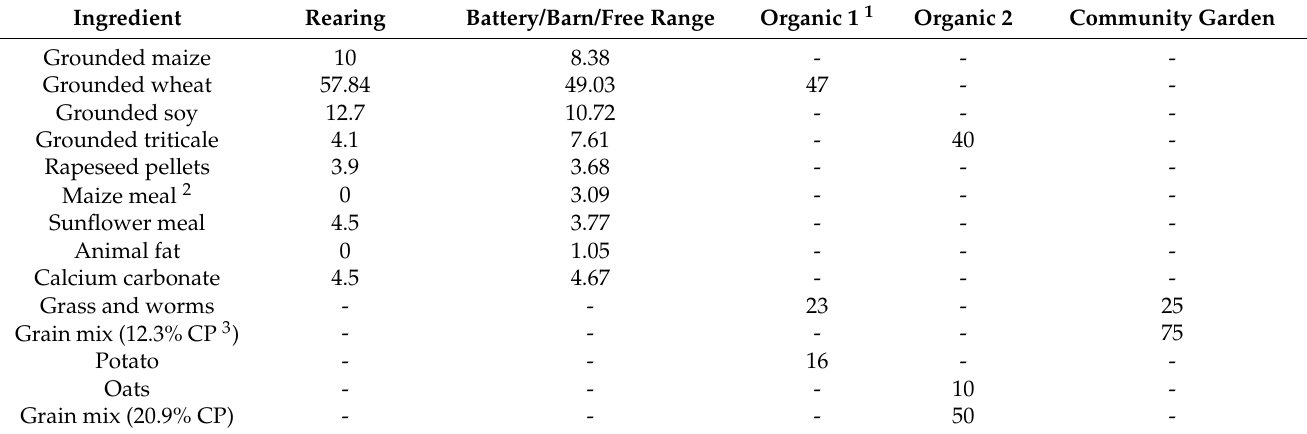
Table 3. Feed composition expressed in percentage of total